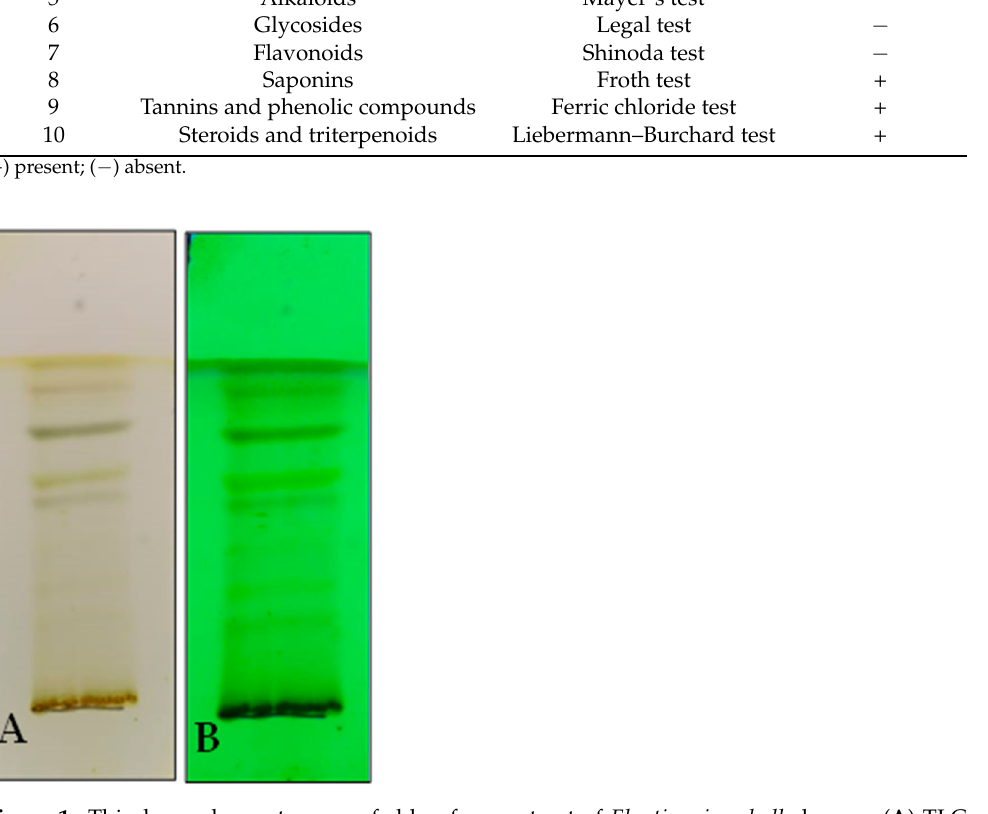
Figure 1. Thin-layer chromatogram of chloroform extract of Ehretia microphylla leaves. ( A ) TLC chromatogram observed in visible light; ( B ) TLC chromatogram observed in UV light at 254 nm in UV chamber. Table 3. Results of TLC fingerprinting of chloroform extract of E. microphylla leaves. S. No.